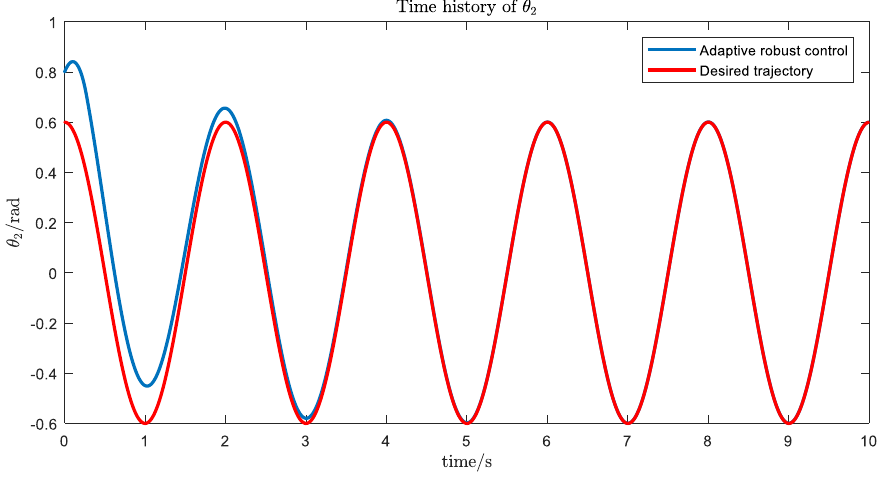
Figure 17. The trajectory tracking of joint 2.